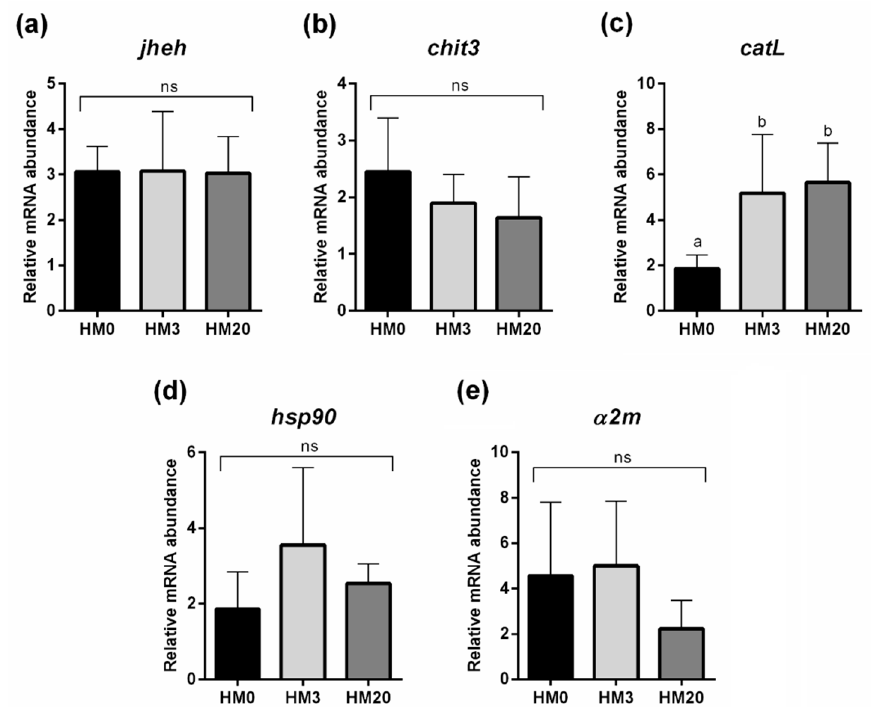
Figure 3. Relative mRNA abundance of genes analyzed in hepatopancreas samples of giant fresh- water prawn fed post-larvae over 60 days with the experimental diets (HM0, HM3, and HM20). ( a ) jheh , ( b ) chit3 , ( c ) catL , ( d ) hsp90 , and ( e ) α 2m . Values are shown as mean ± standard deviation ( n = 15). a,b Different letters indicate significant differences among experimental groups ( p < 0.05). Abbreviations: ns, no significant differences.